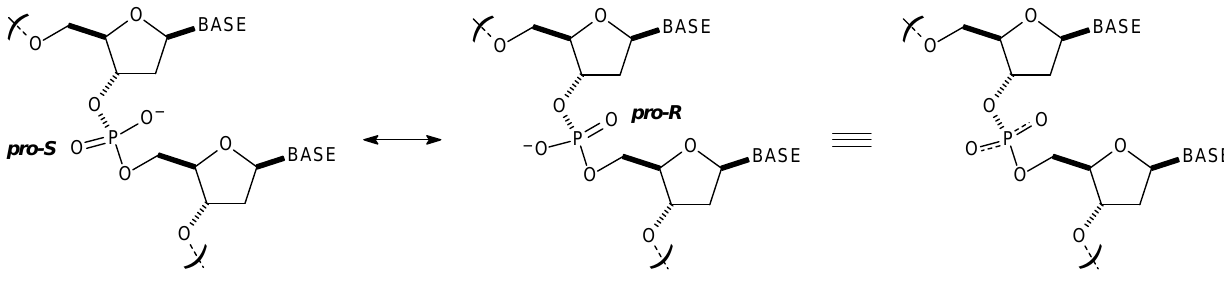
Figure 2. Stereochemistry of the phosphate groups in the DNA biomolecule. Note two possible configurations ( pro-R and pro-S ) in the P=O bound and the negatively charged oxygen atoms. DNA is a negatively charged